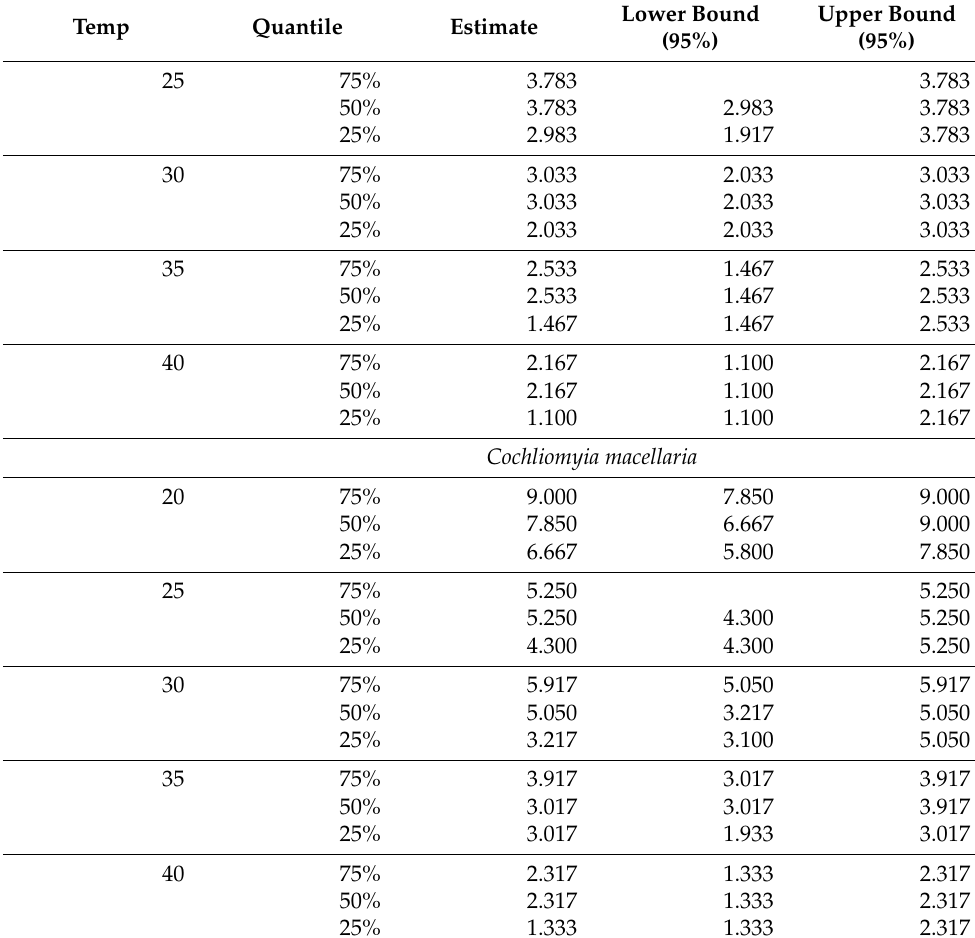
Table 2. Cont. Temp Quantile